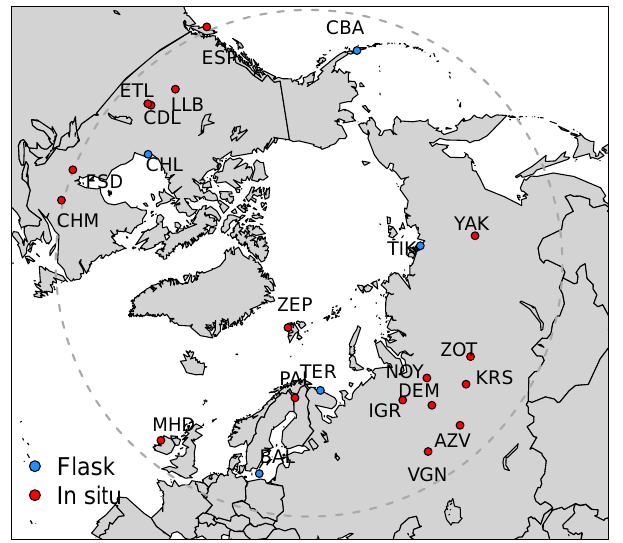
Figure 1. Map showing the atmospheric measurement sites used in the inversion. The grey dashed line indicates the southern bound- ary of the inversion domain at 50 ◦ N. Flask-air sampling sites are indicated in blue and in situ sites in